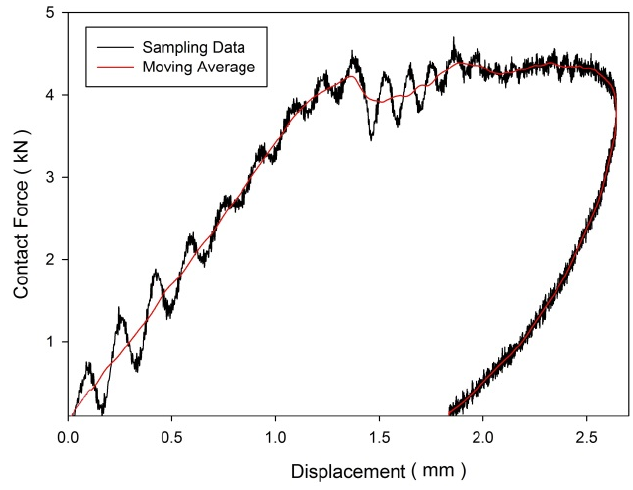
Figure 2. Contact force–displacement of the CPPC laminate at a ply orientation of [±45°] 8 at an energy level of 10 J.